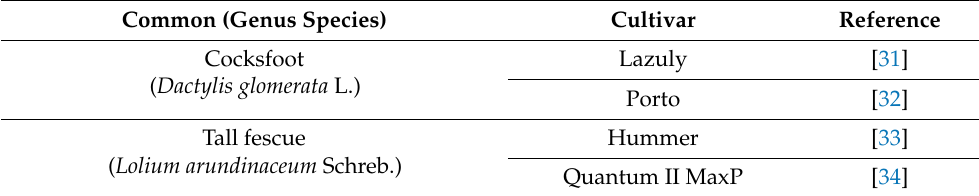
Table 1. Seed materials used in the